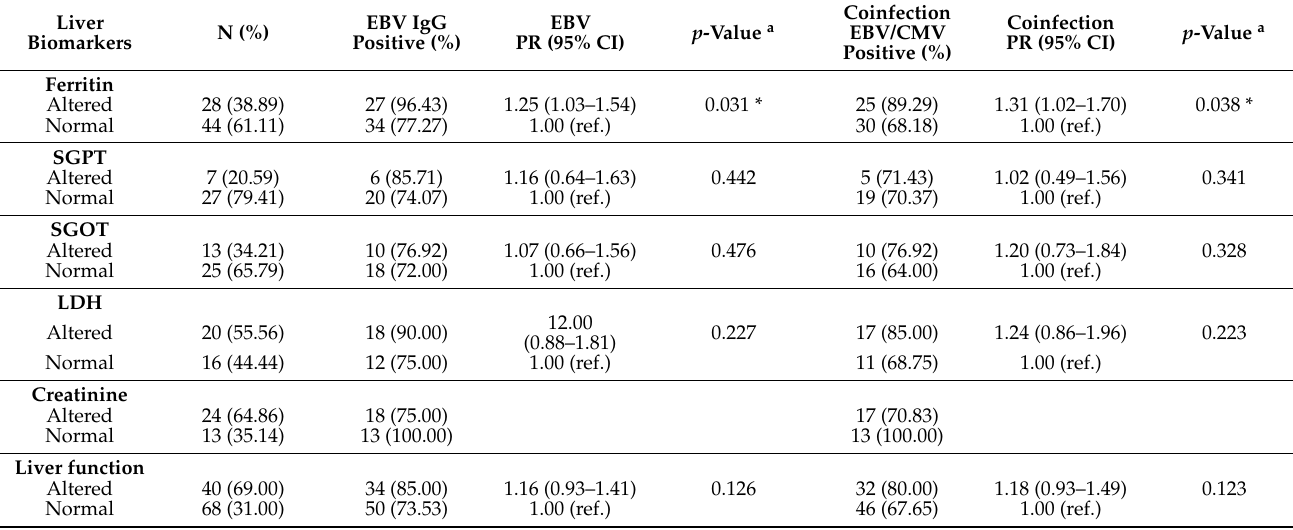
Table 3. Serum level of liver biomarkers according to positivity for EBV infection or EBV/CMV coinfection. Liver